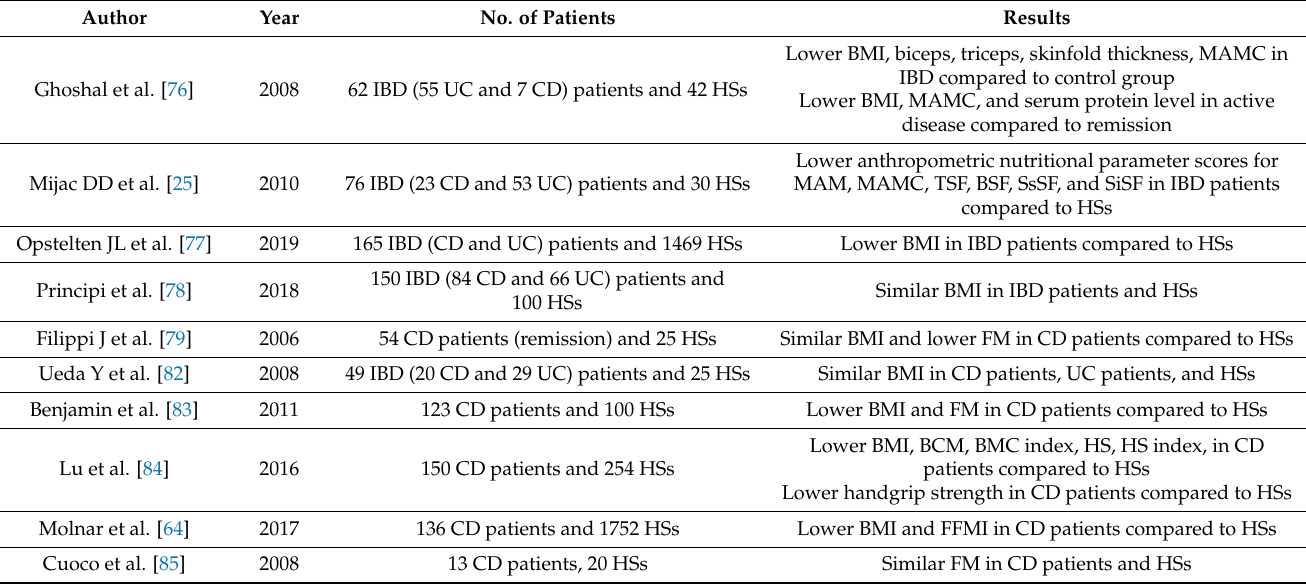
Table 3. Summary of BMI and other anthropometric parameters in IBD